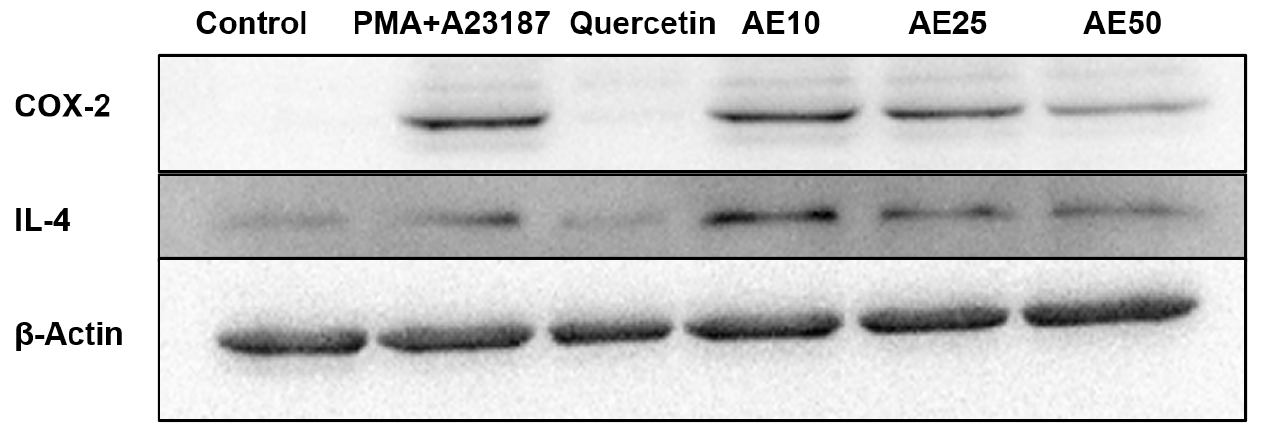
Figure 5. Effect of amber extract on the activation of cytokine-related proteins. After culturing the cells (untreated control), allergen (PMA + A23187), quercetin (6 μ g/mL), or amber extract (10, 25, and 50 μ g/ mL) were added, the levels of IL-4 and COX-2 production were measured by Western blotting.